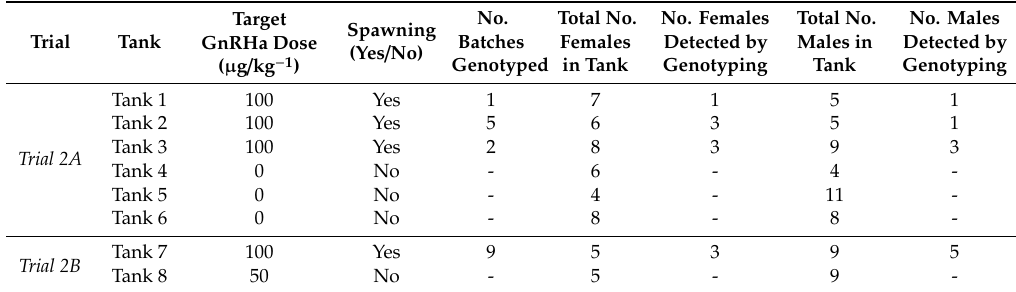
Table 2. Parentage analysis of fertilized eggs obtained from communal spawning events by first filial (F1) h¯apuku ( Polyprion oxygeneios ) during the 2014 spawning season (Trials 2A and 2B). The number of eggs genotyped from each batch was 20 with the exception of one batch (Tank 1) where 11 eggs were genotyped.